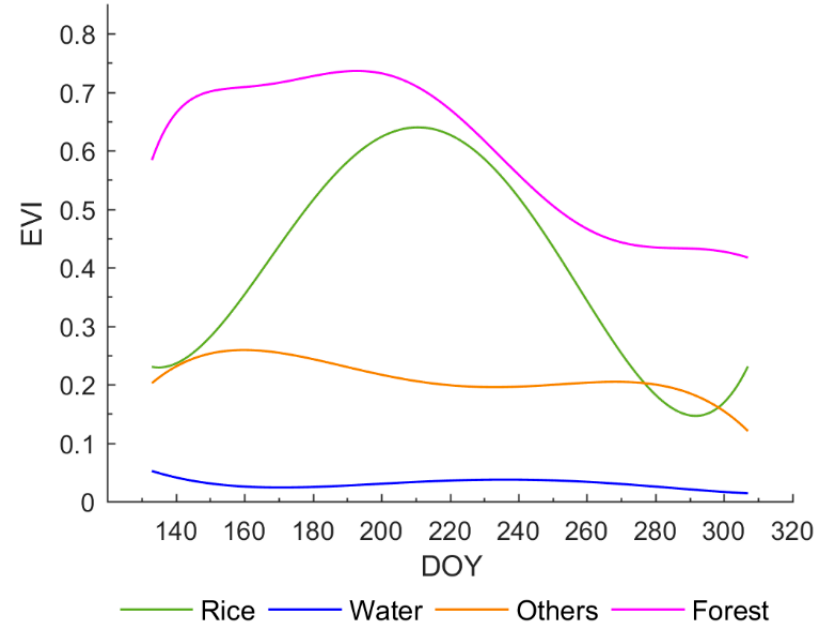
Figure 4. EVI time series curves of four major land types.